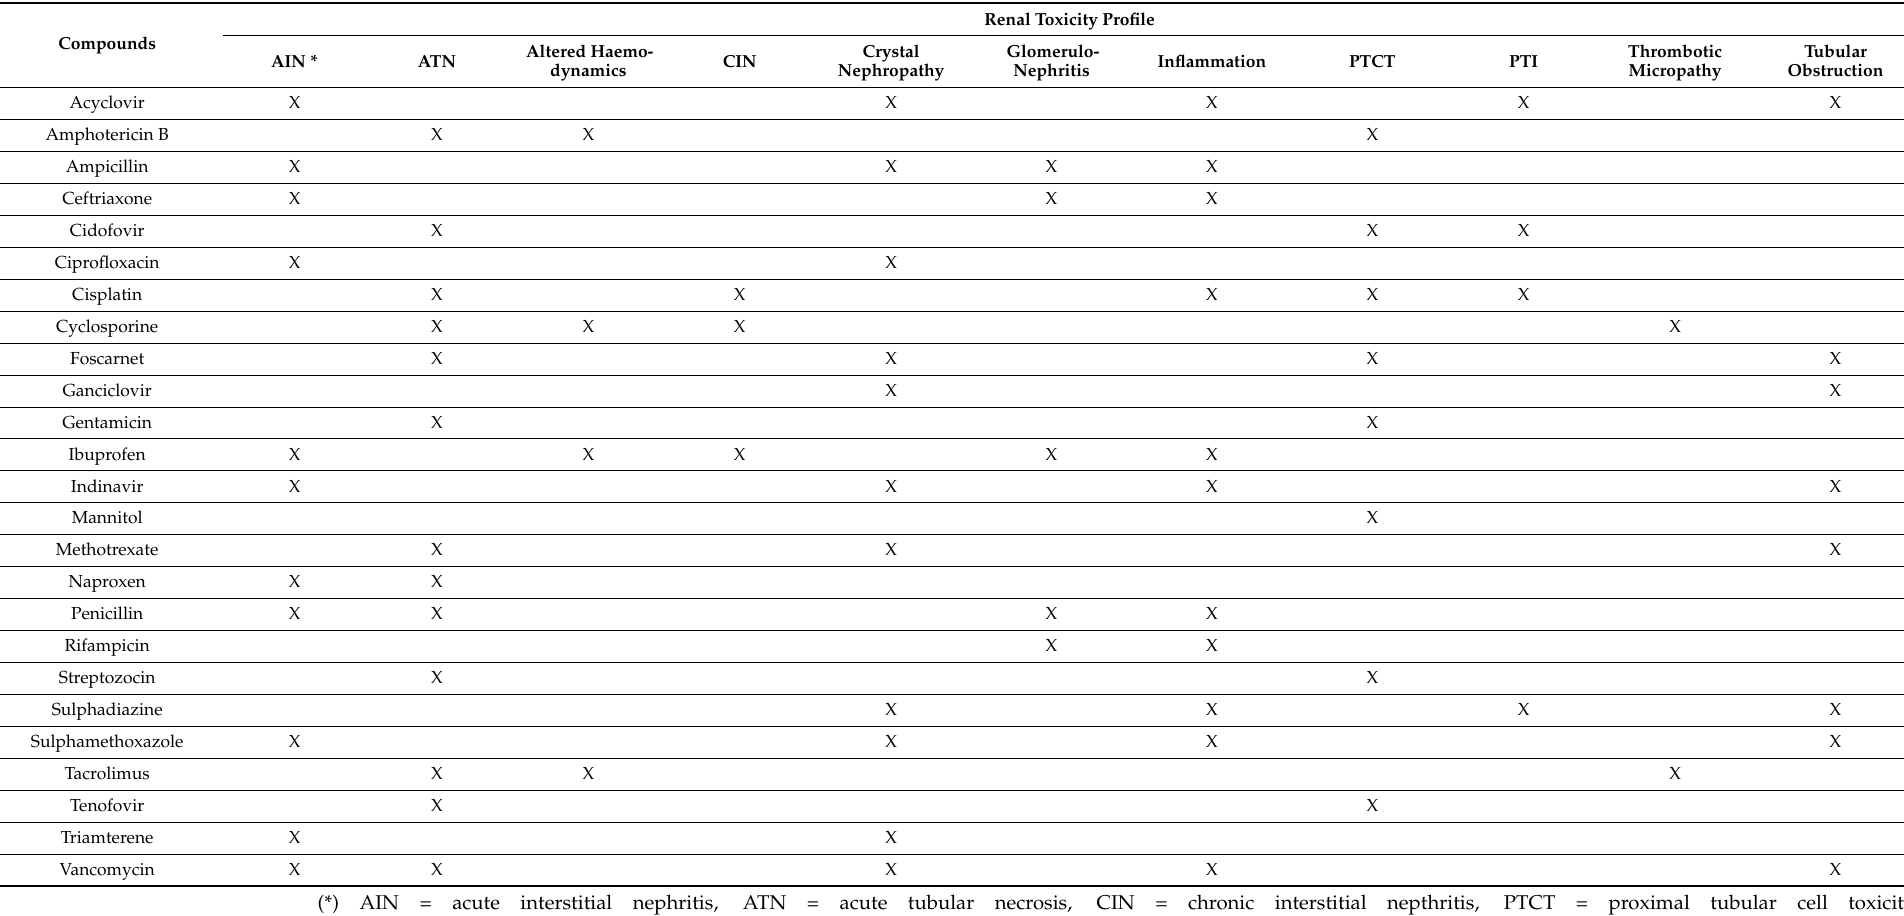
Table 1. Frequently reported nephrotoxic chemicals and their toxicity